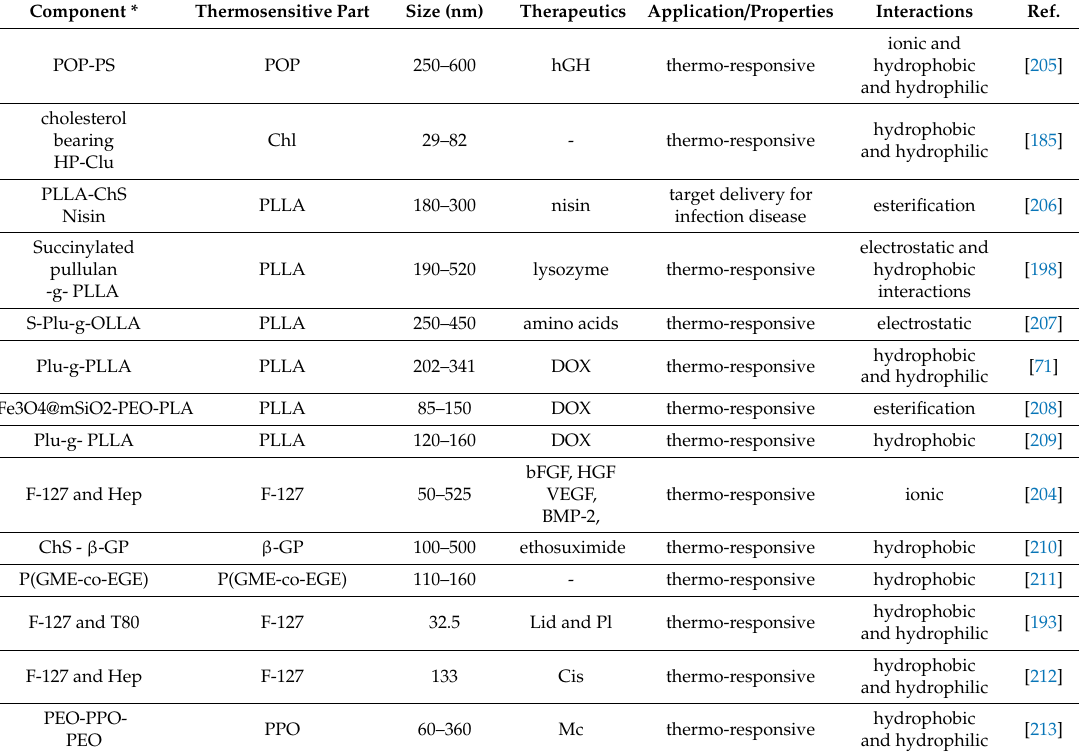
Table 3. Components and applications of investigated thermosensitive nanogels containing hydrophilic polymers bearing hydrophobic groups. ”-“means there is no therapeutic agent introduced in the reference paper and only thermosensitive drug carrier was synthesized and